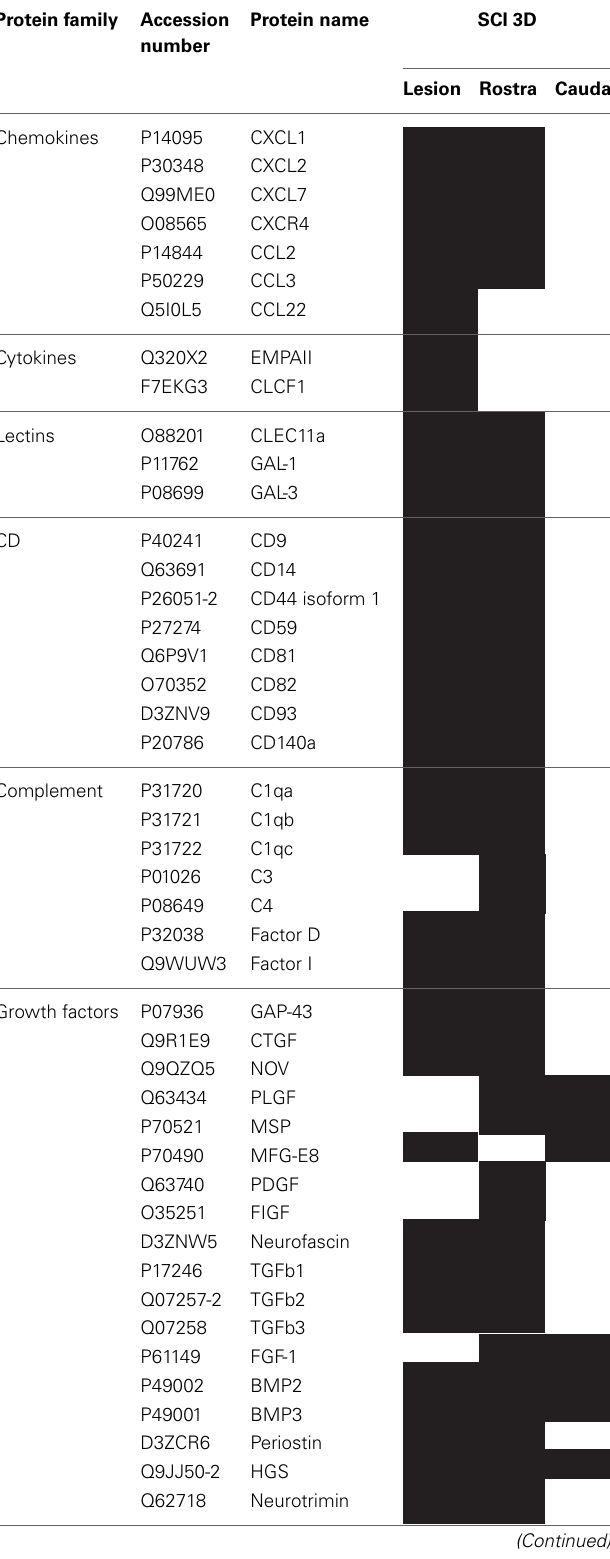
Table 1 | List of proteins identified by shot-gun issue from CM (24h) of central lesion, adjacent rostral and caudal segments after SCI at 3